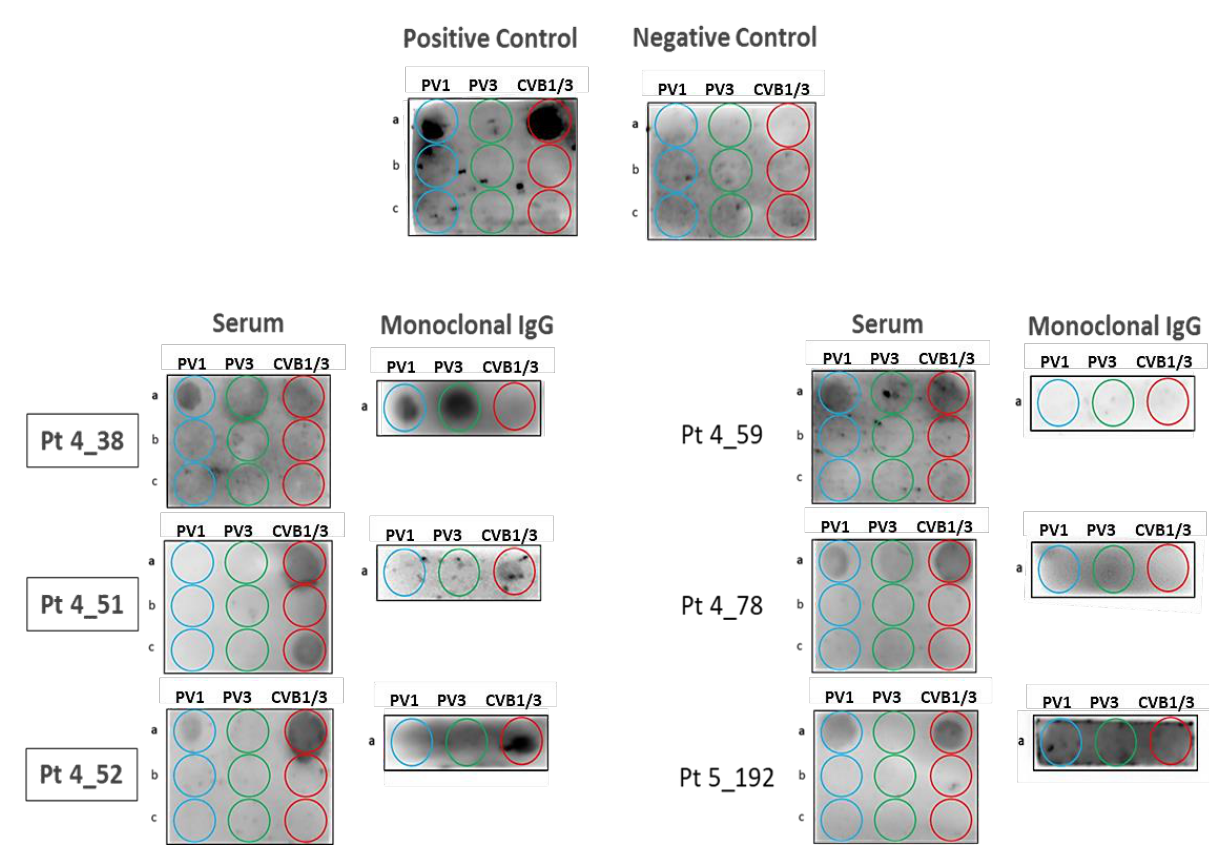
Figure 3. Results of the “PV/CVB” Dot Blotting Assays obtained for the 6 Monoclonal Igs found to be Specific for the PALTAV/AETG Epitopes with the PEPperCHIP ® Infectious Epitope Arrays. Membranes were spotted with the following peptides: (a) HP-1a, HP-3a and HC-a, respectively relevant to PV1, PV3 and CVB1/B3; (b) irrelevant HP-1b, HP-3b and HC-b peptides; (c) irrelevant HP-1c, HP-3c and HC-c peptides (see Supplementary Table S2), then incubated with positive or negative controls or samples of serum from patients. After validation that no signal was obtained with irrelevant peptides for serum samples, purified monoclonal Igs were incubated with relevant peptides only. Immunoblot revelation with secondary antibodies (Materials & Methods). The assay confirmed that the purified monoclonal IgG of MGUS patients 4_38, 4_51 and 4_52 (in bold, left panel) bound specifically to PALTAVETG or PALTAAETG epitopes.